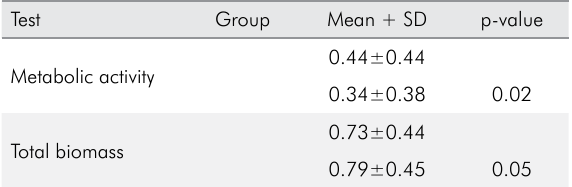
Table 2. Evaluation of metabolic activity and total biomass of biofilms in the control group (CG) and experimental (LG)